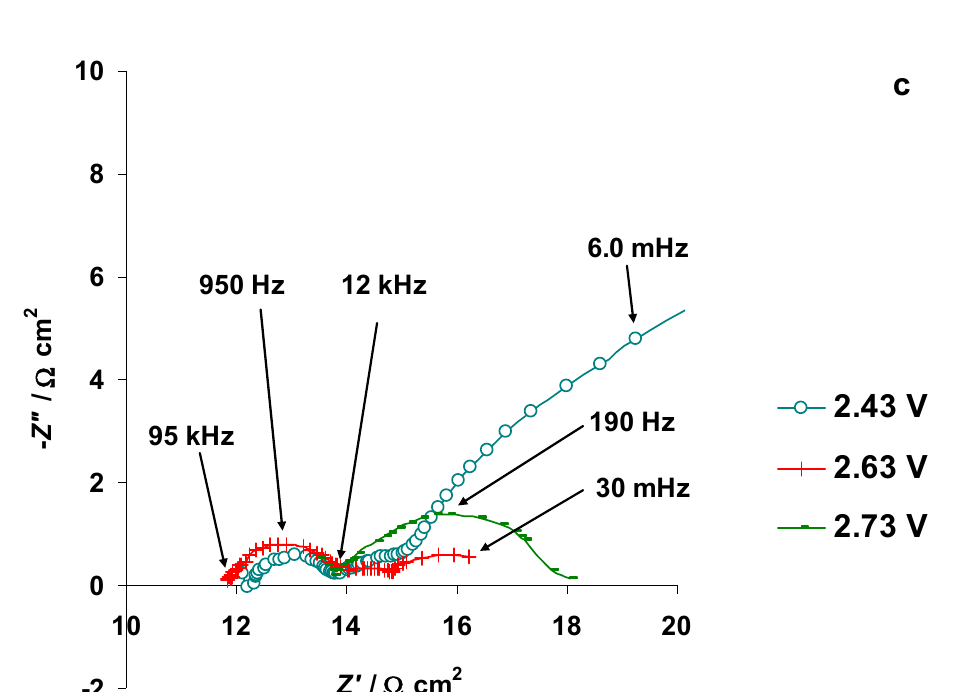
Figure 13. Electrochemical impedance spectroscopy Nyquist plots measured for the 5 wt % EMImBr solution in the EMImBF 4 –C(Mo 2 C) system at variable positive potentials: ( a ) from 0.03 to 2.03 V; ( b )